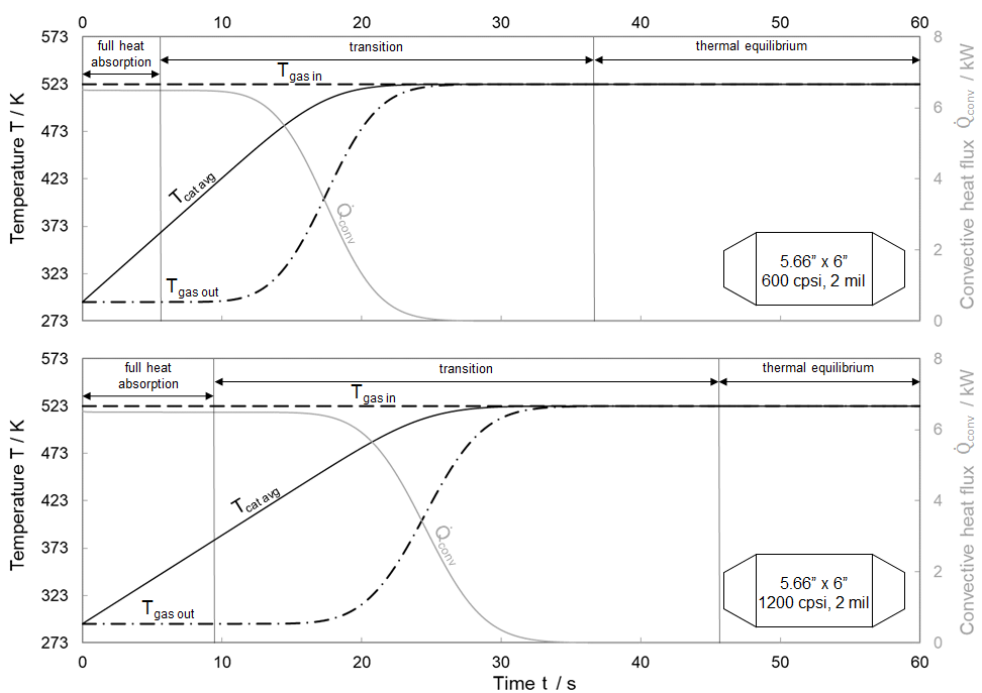
Figure 16. Comparison of 600 cpsi, 2 mil (top) and 1200 cpsi, 2 mil (bottom) at steady state heat-up at a flow rate of 100 kg/h and 523 K.